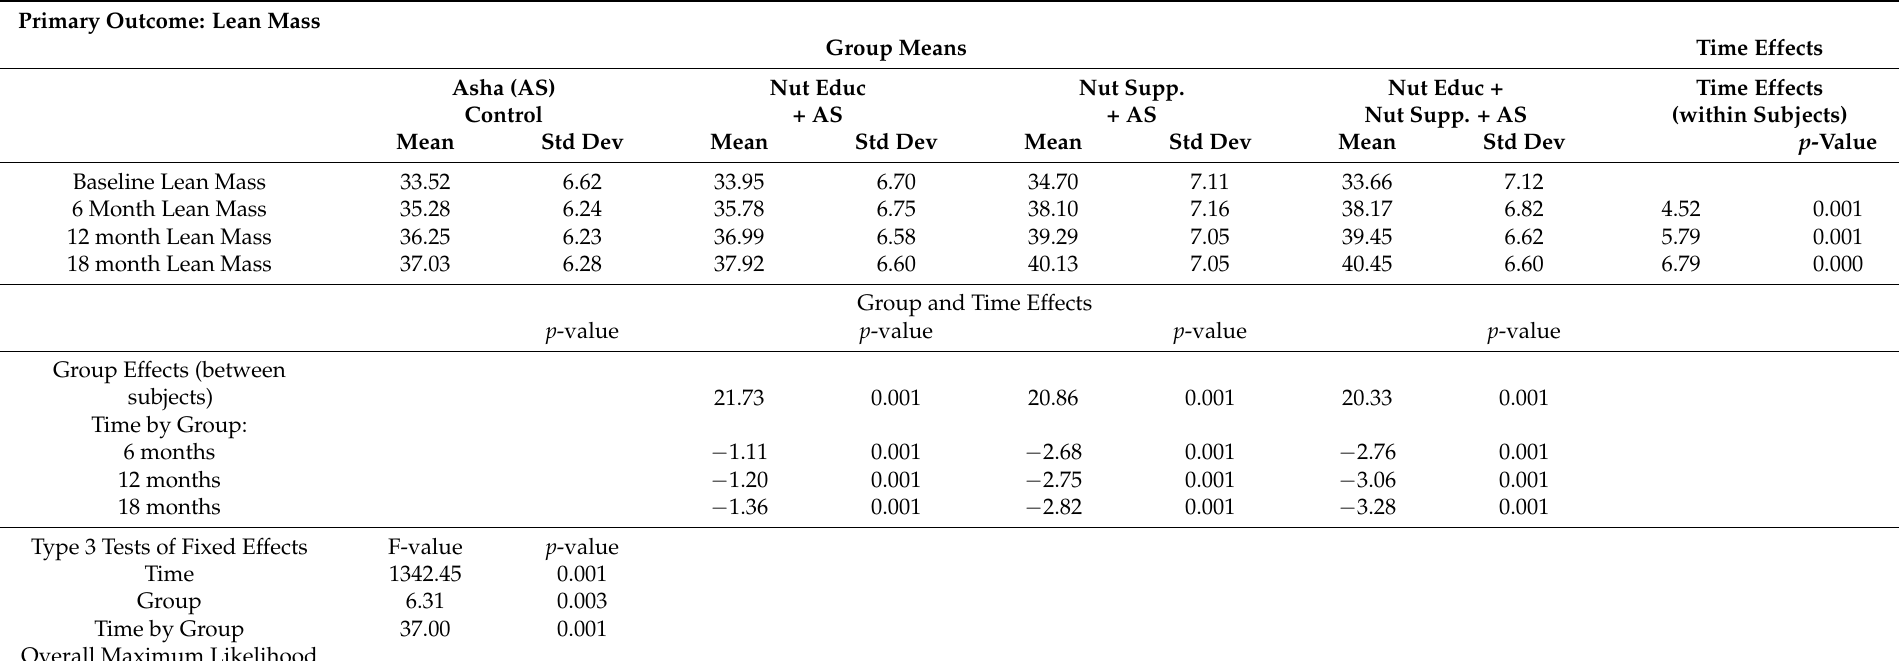
Table 3. Group Means and Mixed Model Effects for Primary and Secondary Outcomes 1